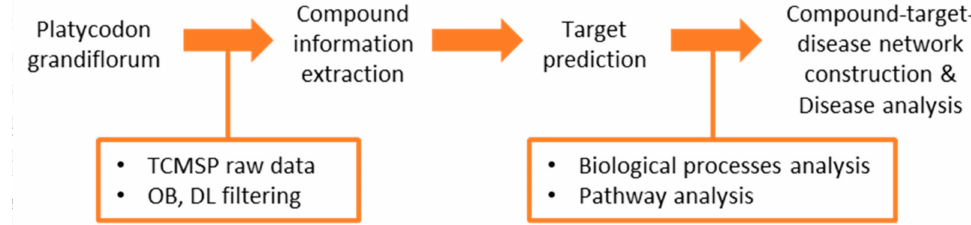
Figure 1. Framework of network pharmacological analysis of Platycodon grandiflorum (PG); TCMSP: Traditional Chinese Medicine Systems Pharmacology database; OB: oral bioavailability; DL: